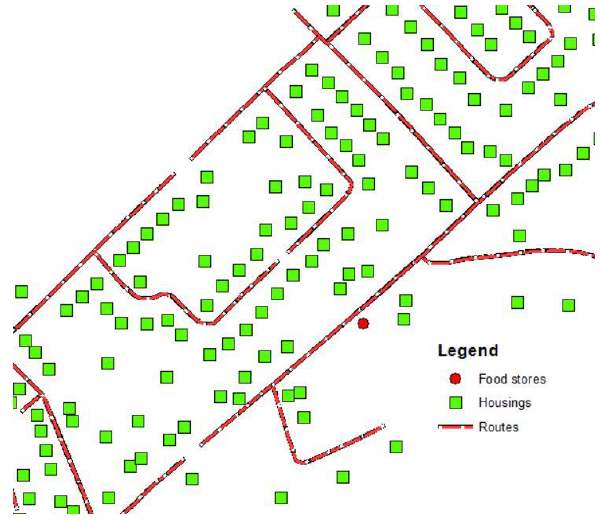
Figure 1. Food desert store accessibility calculation.